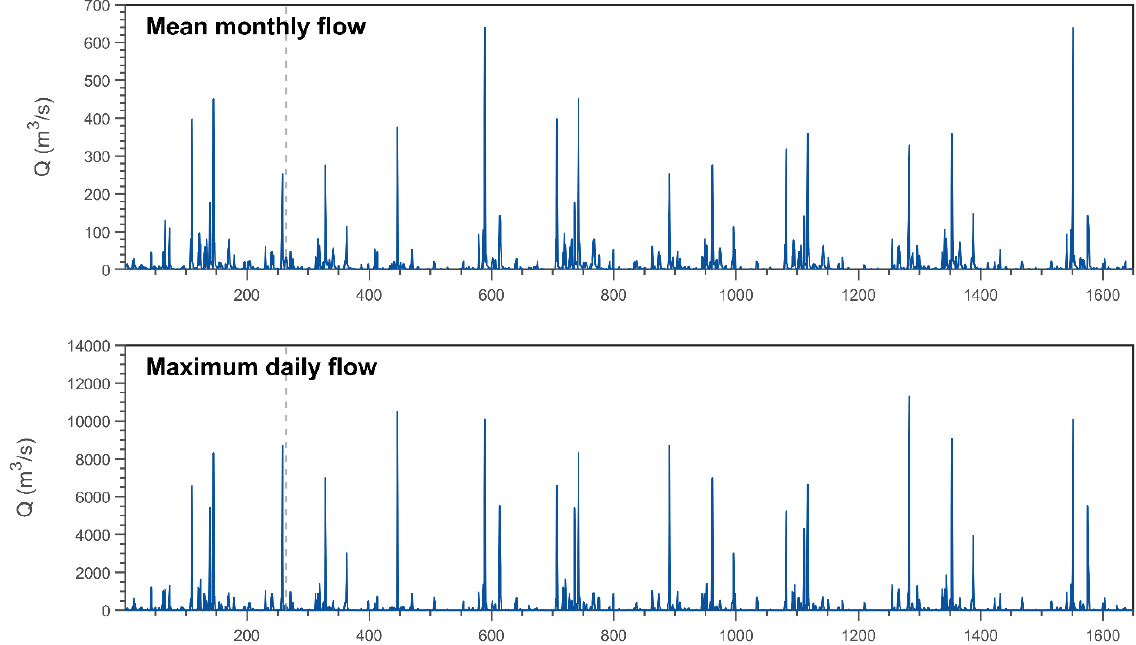
Figure A2. Mean monthly (top) and maximum daily (bottom) synthetic inflow hydrographs. The dashed line indicates the construction of the Wivenhoe